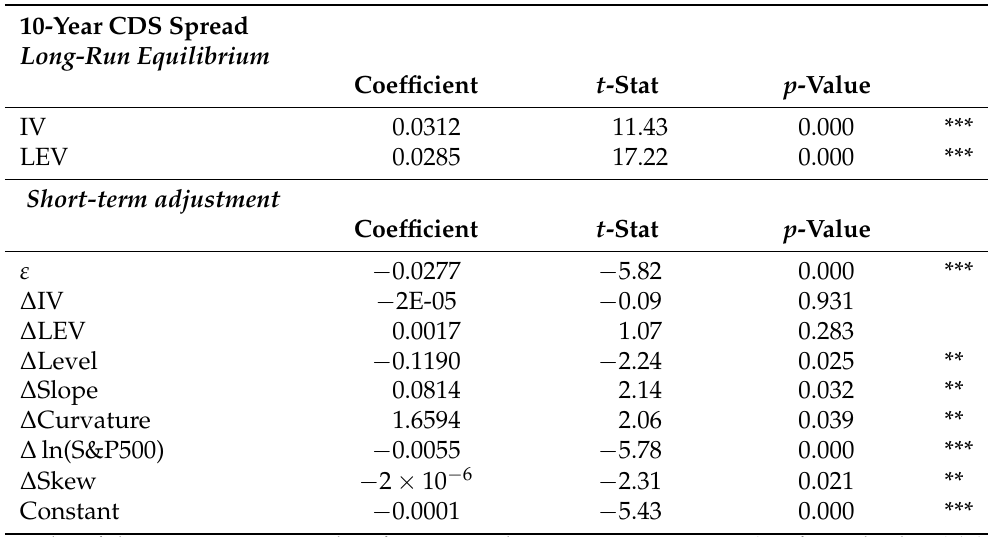
Table 13. ECM for 10-year CDS spreads using the average implied volatility of put options instead of σ S . Similar results are obtained; however, neither the implied volatility nor leverage are significant in the short-term adjustment equation. Additionally, ∆ Level, ∆ Slope, ∆ Curvature and ∆ Skew are significant at the 5% significance level